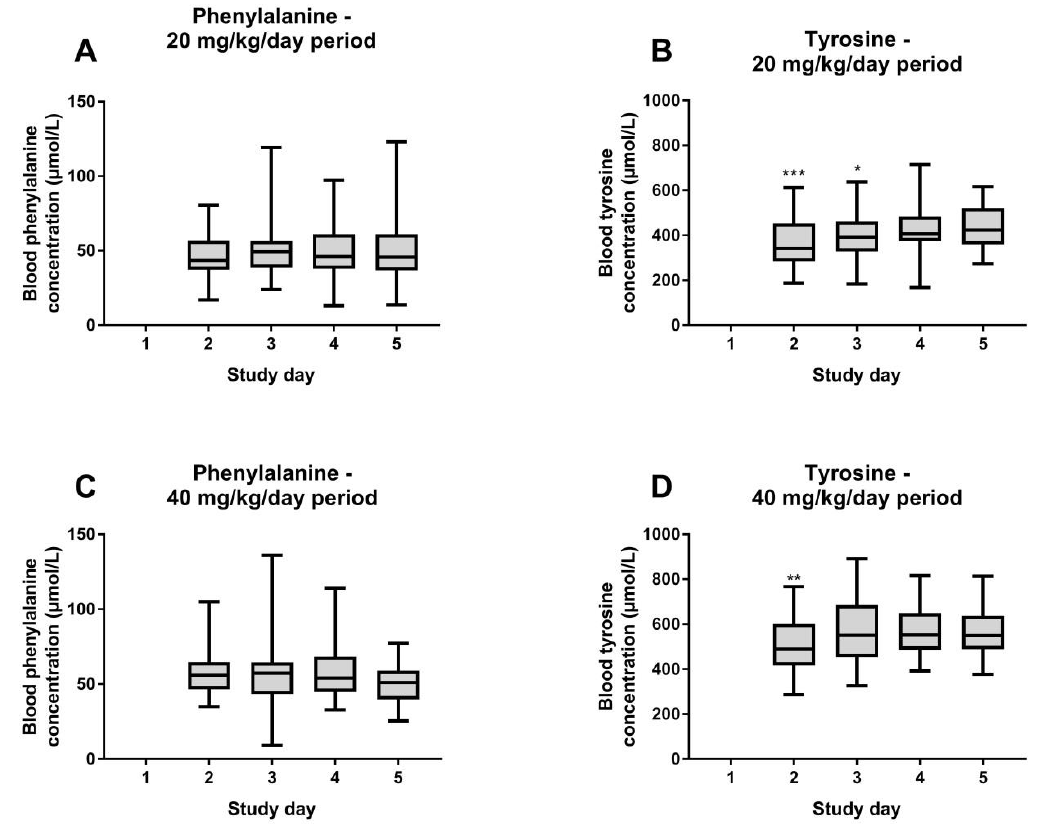
Figure 2. Day-to-day variation of blood phenylalanine and tyrosine concentrations while receiving 20 ( A , B ) and 40 mg / kg / day ( C , D ) phenylalanine supplementation, presented as min–max whiskers. In both periods, no bloodspots were taken at the first day of the study period followed by three bloodspots a day during four consecutive days. Phenylalanine and tyrosine concentrations at each day were compared to the phenylalanine and tyrosine concentrations at the last study day of that study period. * p < 0.05, ** p < 0.01, *** p < 0.001.